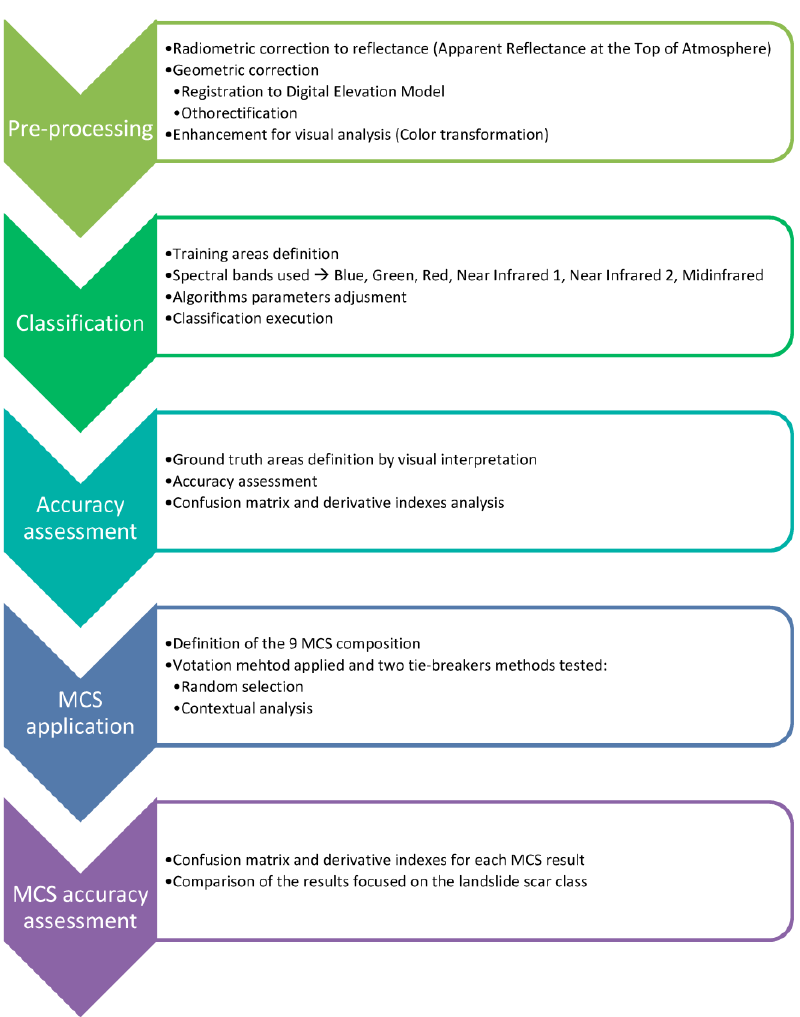
Figure 2. Flowchart of the methodology used in this study.